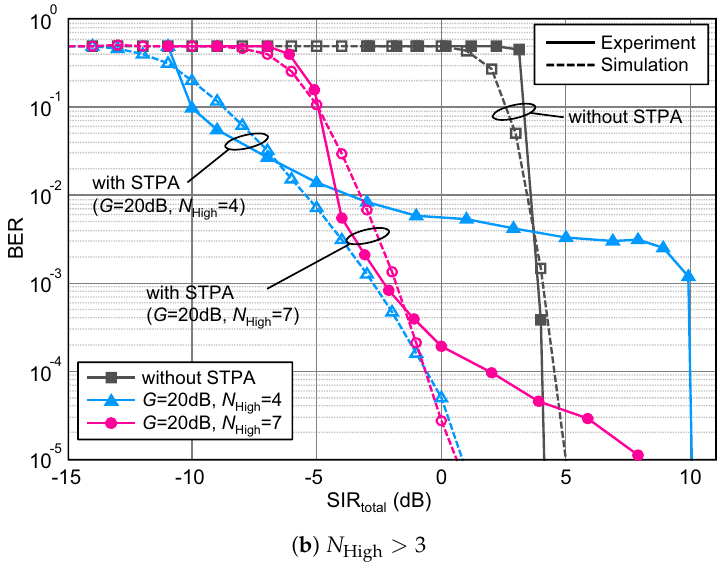
Figure 11. BER performance of the primary system. ( a ) N High ≤ 3; ( b ) N High >